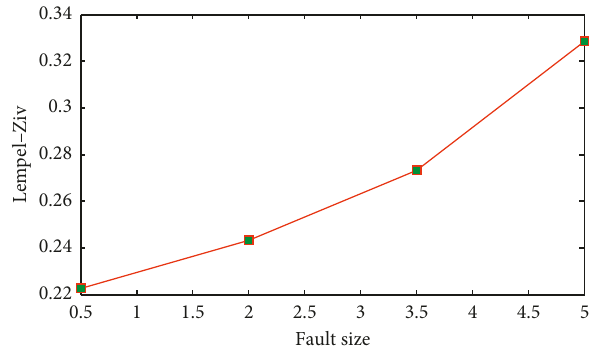
Figure 9: The Lempel–Ziv trend diagram of outer race defect.